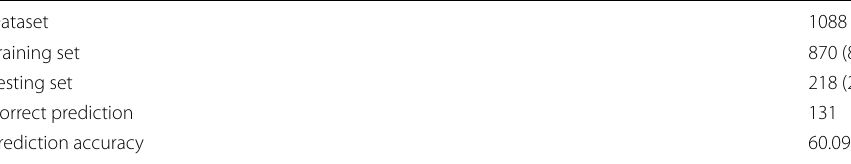
Table 16 Topics testing set prediction result